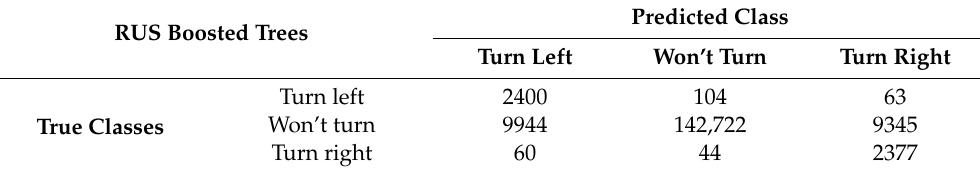
Table 5. The confusion matrix of the RUS boosted trees trained by 61-day data.